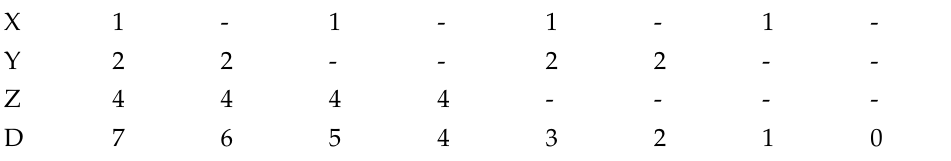
Table 2. How to calculate the value of D, which represents the divisible sides of a cuboid.